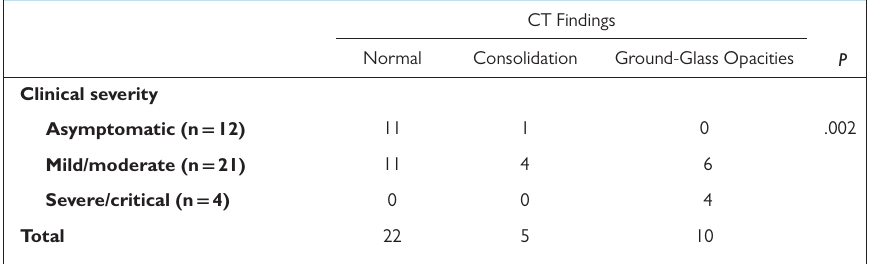
Table 5. Distribution of Chest Tomography Findings According to Clinical Severity